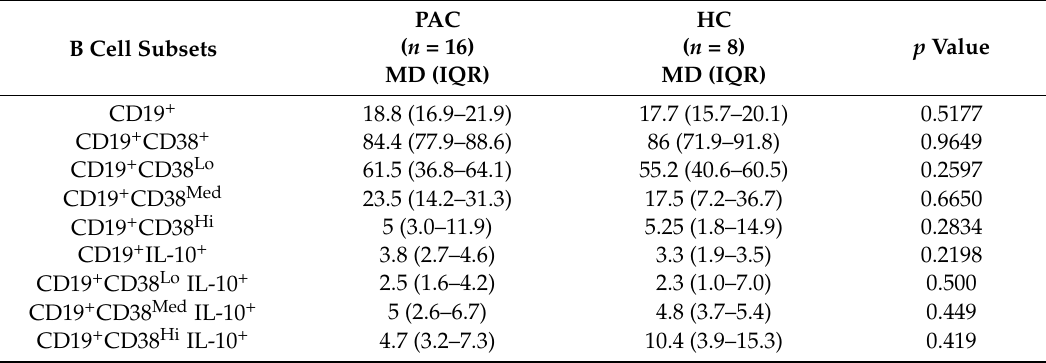
Table 2. Percentages of B cell subsets in patients with perennial allergic conjunctivitis (PAC) and healthy controls (HC). B Cell